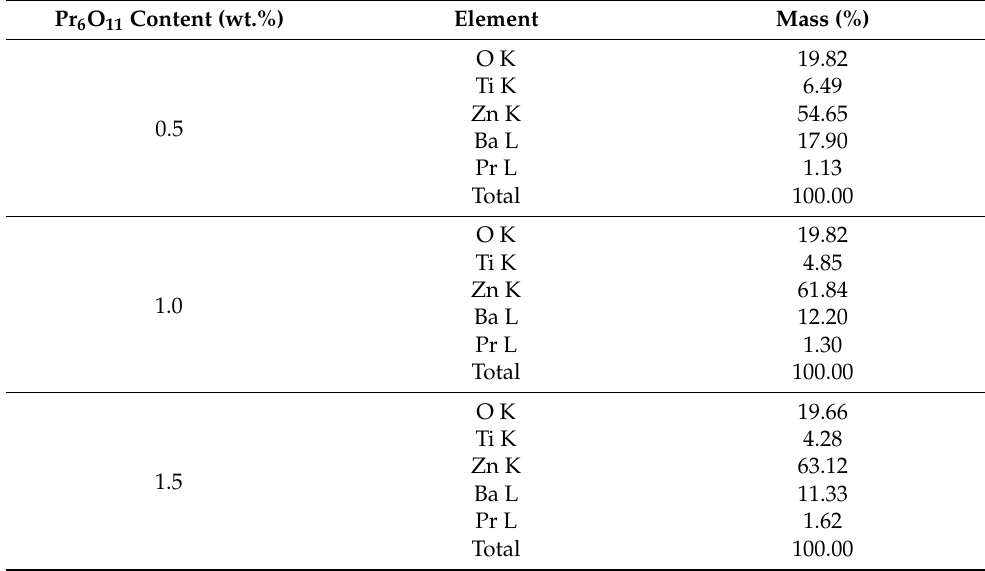
Table 1. The element contents of ZnO-BaTiO 3 varistor ceramics with different amounts of Pr 6 O 11 compositions.